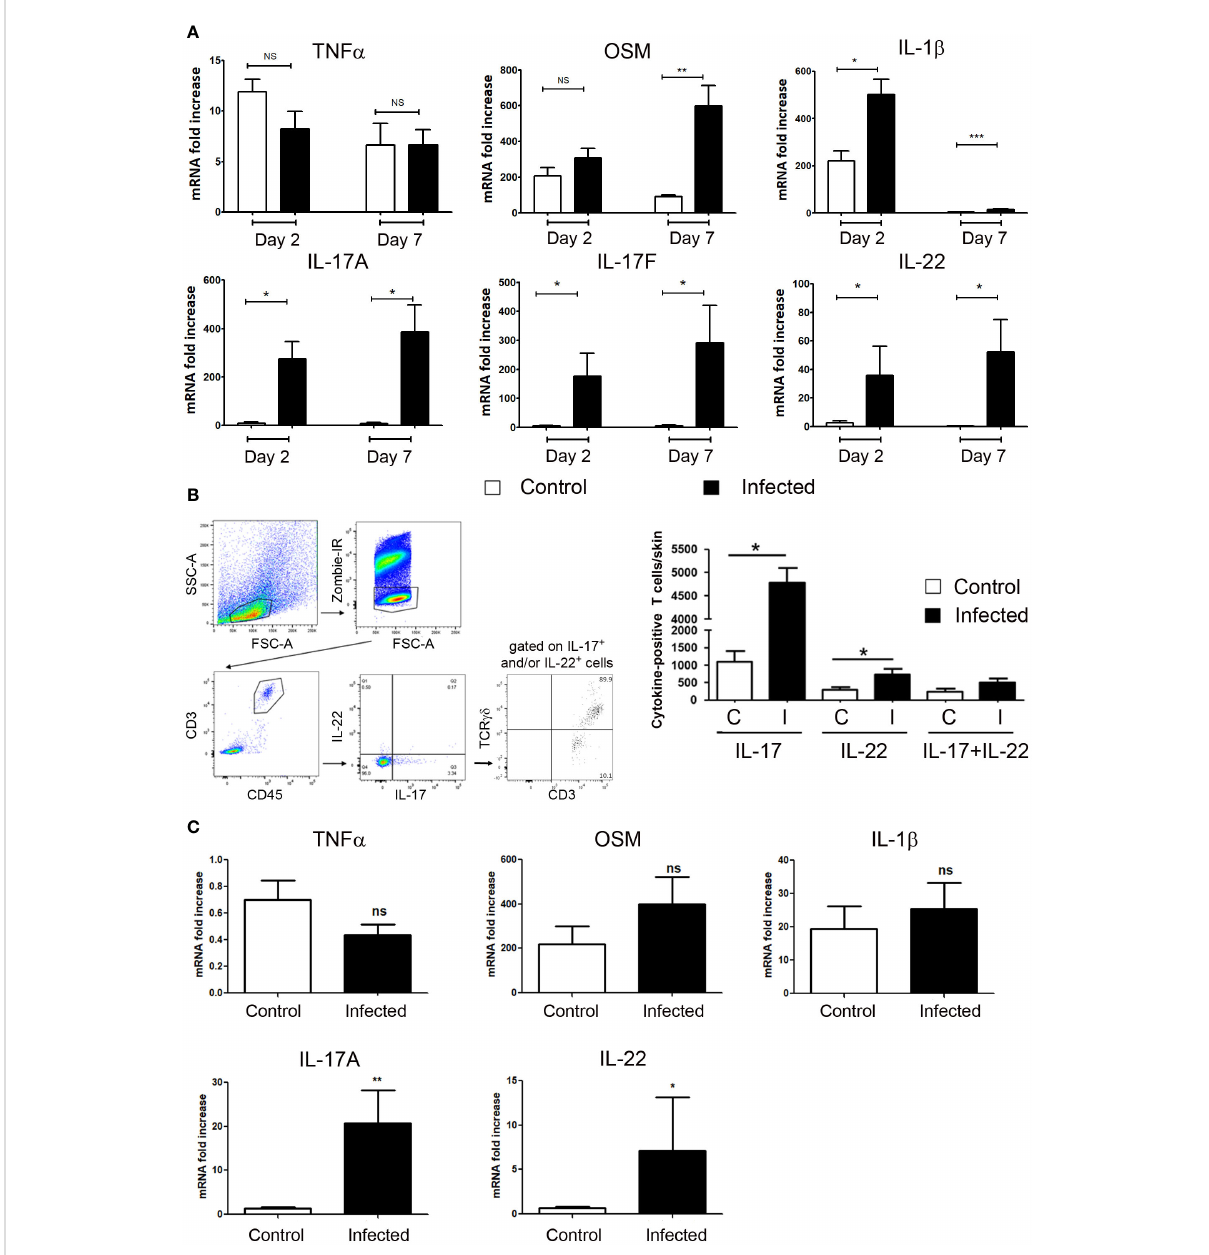
FIGURE 2 IL-17 and IL-22 are produced by T cells in infected skin excisional wounds. (A) Cytokine mRNA expression into control or S. aureus and P. aeruginosa infected wounds were determined by RT-qPCR at day 2 and day 7. Each bar represents the mRNA fold increase over normal skin, in control-wounded skin (white) or infected wounded skin (black). The data correspond to the mean +/- SEM of 4 independent experiments; * p <0.05, ** p <0.01, *** p <0.001; (B) Five days after wound infection by the bacterial mixture (infected, I) or application of a control PBS solution (uninfected, C), an 8 cm 2 biopsy of back skin including 4 excisional wounds was collected and underwent mechanical and enzymatic treatment for cell dissociation before analysis by fl ow cytometry. (B, left) Representative gating strategy to analyze IL-17 and IL-22 expressions in CD3- positive T cells and TCR gd expression among this IL-17 + and/or IL-22 + , CD3 + T cell population. (B, right) Quantitative analysis of the number of IL-17-, IL-22- or IL-17/IL-22-positive T cells in fi ltrating infected or non-infected wounded skins. Data (mean +/- SEM) are representative of one out from three independent experiments including 5 mice per group. *p < 0.05. (C) IL-17A, IL-22, OSM, IL-1 b and TNF a mRNA levels were determined by quantitative PCR in human wounds. Each bar represents the mRNA fold increase over normal human skin in uninfected (white) or infected wounded skin (black). The data correspond to the mean +/- SEM of 12 uninfected and 7 infected skin wound samples; * p <0.05, ** p <0.01, *** p <0.001. ns, not signi fi